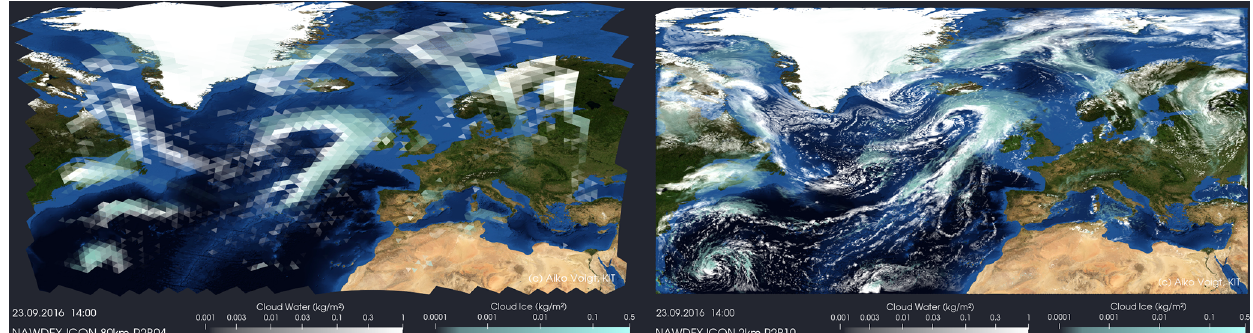
Figure 1. Illustrations of clouds simulated by a low-resolution version of the ICON atmosphere model with 80km horizontal grid spacing (left) and a high-resolution version with 2km horizontal grid spacing (right). The triangular grid structure is visible in the left panel.